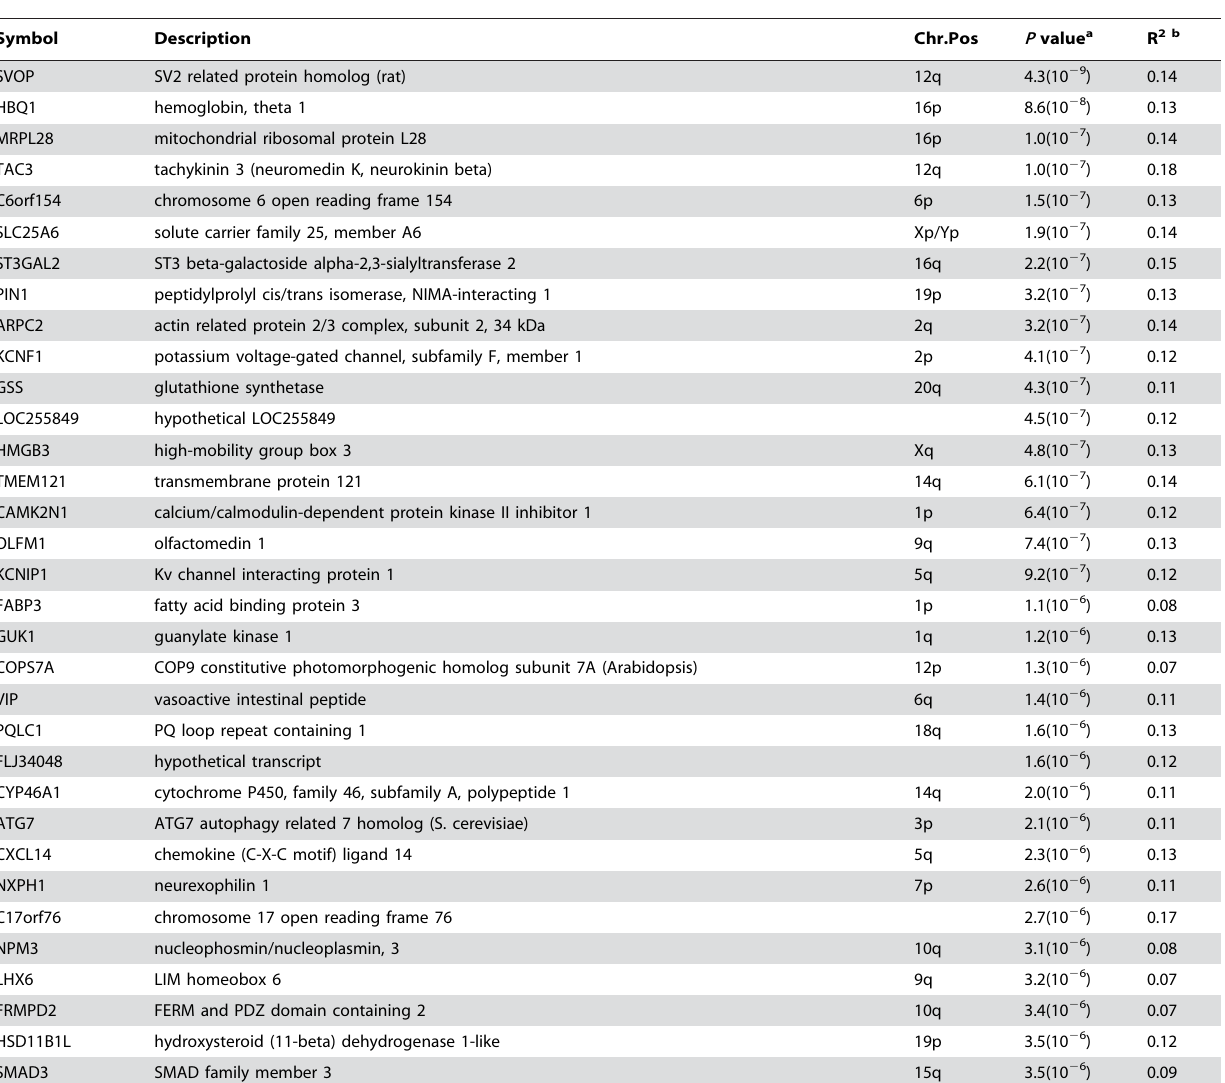
Table 1. Genes whose expression decreases with age in the human brain.